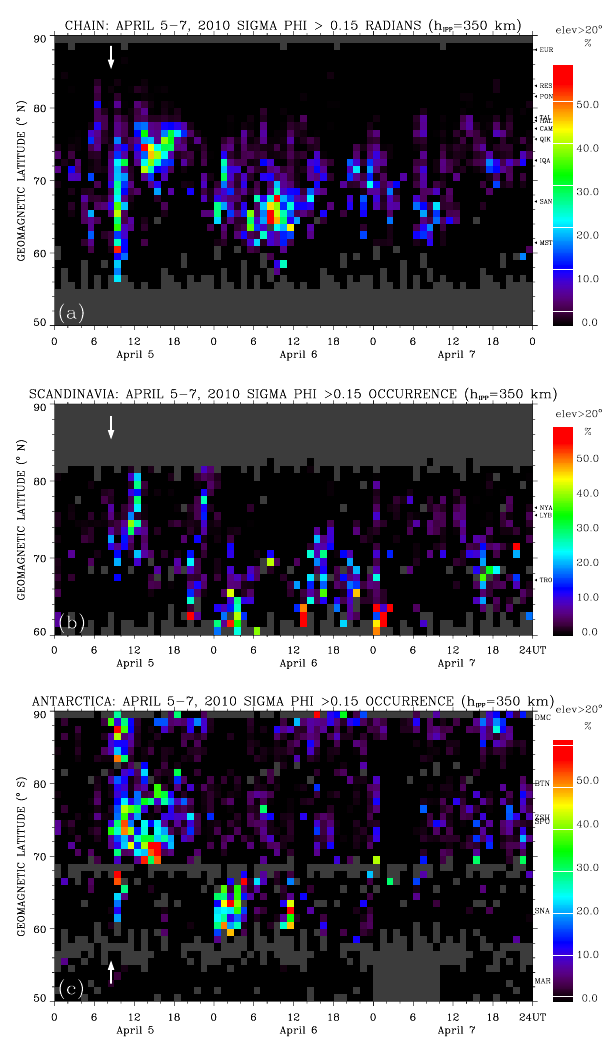
Fig. 8. Phase scintillation occurrence as a function of UT and CGM latitude for (a) CHAIN, (b) North European and (c) Antarctic ar- rays for 5–7 April 2010. The superposed white arrow indicates a substorm onset just after the arrival of the upstream